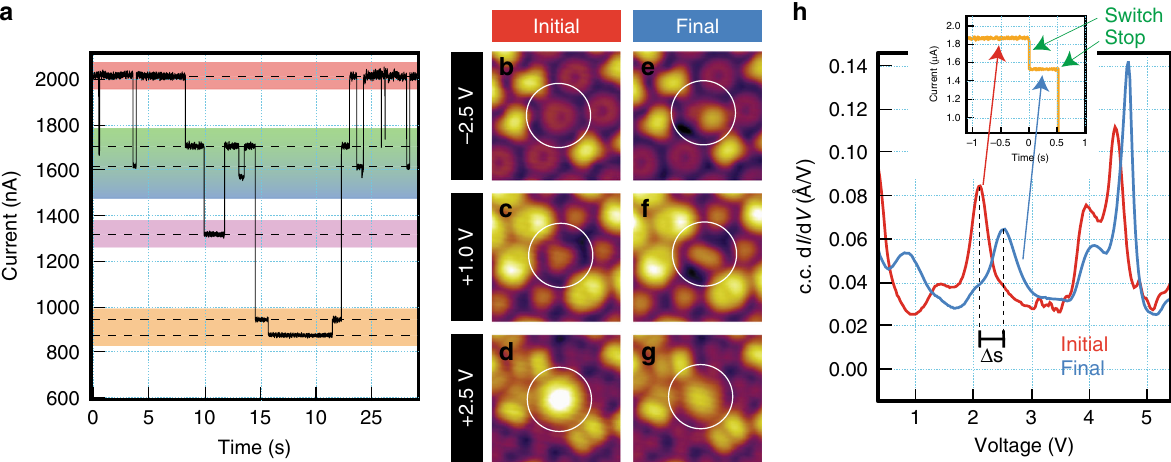
Fig. 3 Microscopy and spectroscopy evidence for Li@C 60 switching. a I ( t ) spectrum illustrating conductance changes of the Li@C 60 upon the application of + 5.0V and 2.0 μ A over 30 s. The reversible alterations in the conductance are seen to be con fi ned to several distinct levels. b – h Before and after STM data illustrating a single switch event for a Li@C 60 . b and e Filled states images at – 2.5V, 0.1 nA; c and f Empty states images at + 1 V, 0.1 nA; d and g Empty states images at + 2.5V, 0.1nA, for which the contrast is dominated by the S-SAMO resonance. h Constant-current d I /d V spectra acquired before (red) and after (blue) the switch event reported in b – g . This direct comparison allows for spectroscopic identi fi cation of the energy shift of the S-SAMO resonance. The inset displays the I ( t ) data (acquired at 5 V and 1.85 μ A) used to monitor the switch event by recording the associated reduction in